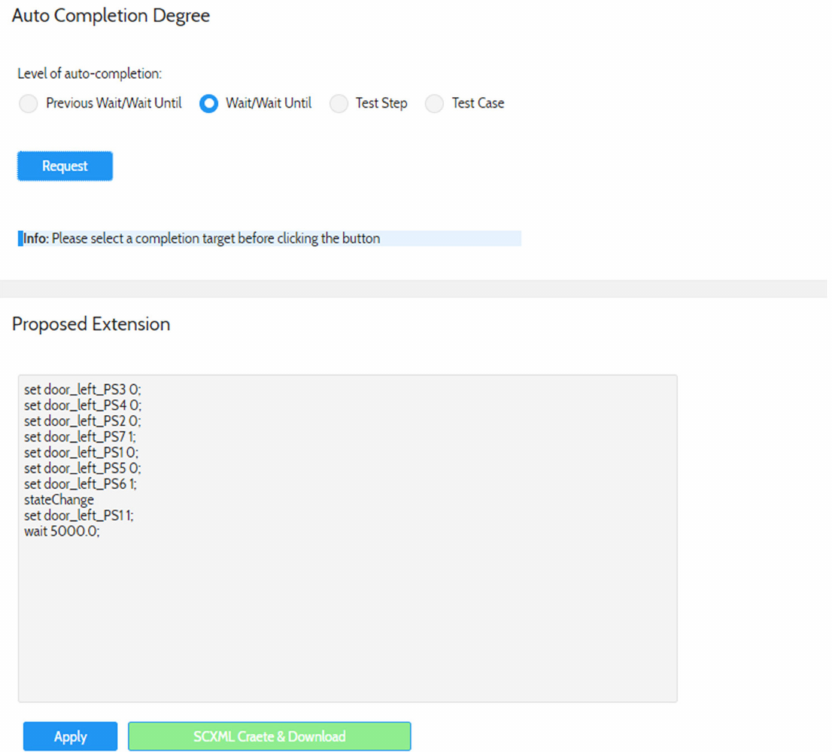
Figure 18. Screenshot of http://testadvisor.eu (accessed on 5 January 2023) for the auto-completion of the pattern with the scope wait/wait